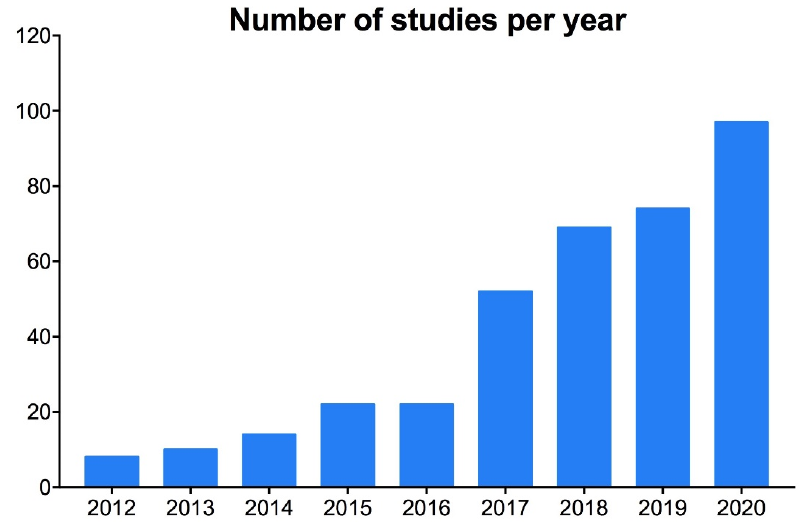
Figure 2. Publication trends of RWS. Distribution of the 433 retrieved RWS according to the year of publication.